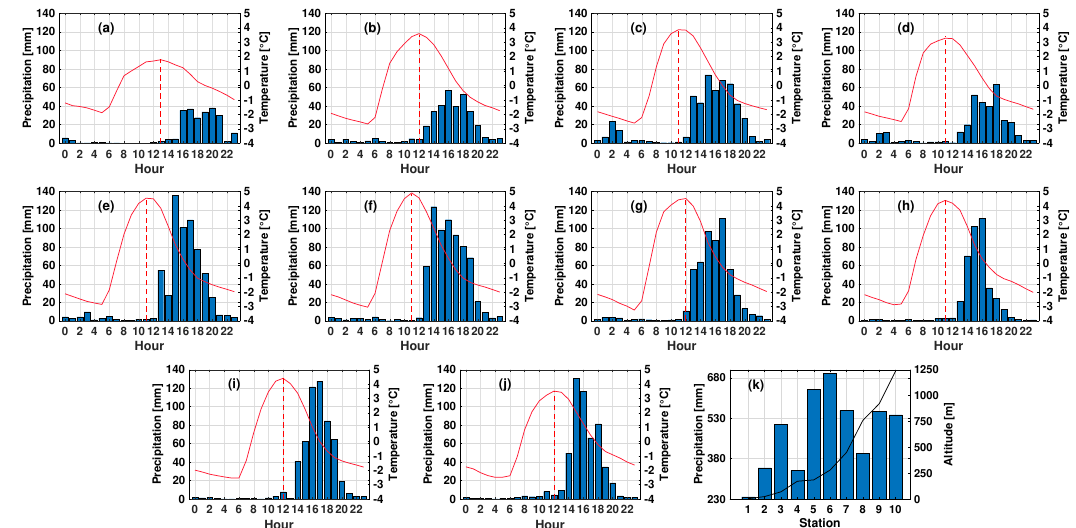
Figure 2. Hourly mean temperature anomalies ( ◦ C) with respect to daily mean (right axis; the red, vertical dashed line represents the hour of maximum temperature) and total hourly precipitation (mm) distribution (left axis) for ( a ) Puntarenas, ( b ) Guacalillo, ( c ) Capulín, ( d ) Lagunilla, ( e ) Orotina, ( f ) Hacienda Vieja, ( g ) Escuela de Ganadería, ( h ) La Garita, ( i ) JSIA, and ( j ) CIGEFI. Panel ( k ) shows the total precipitation (mm; left axis) at each station as a function of altitude (m; right axis and solid black